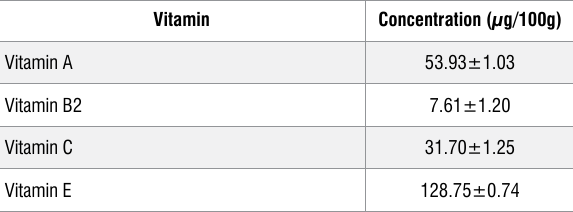
Vitamin content of yellow variety of tiger